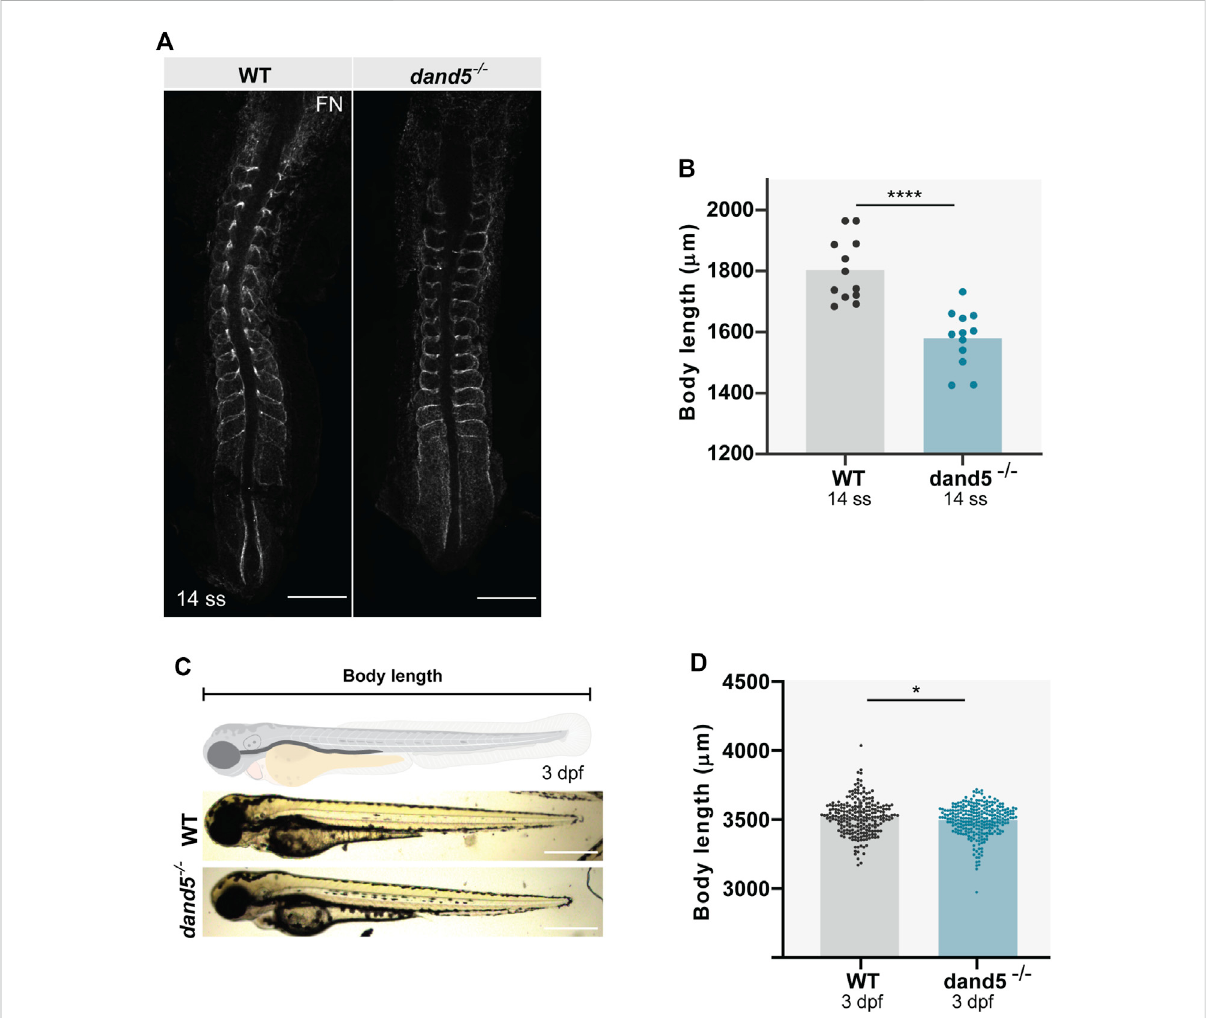
FIGURE 8 Bodysizeandsomitemorphology inWTand dand5 − / − embryos. (A) Fibronectin(FN)immunostainingshows somitebordersinWTand dand5 − / − embryosat14ss.Scalebar=100 µm.Thetopisanterior;thebottomisposterior. (B) ComparisonofWTand dand5 − / − bodylengthat14ss. (C) WTand dand5 − / − 3 dpf larvae and schematic representation of body length measurements. Scale bar = 500 µm. (D) Comparison of body length measurementsbetweenWT( N =234)and dand5 − / − ( N =271)3dpflarvae.GrayrepresentsWTembryos,andbluerepresents dand5 − / − embryos. t -testunpairedcomparison.Barsrepresentmeanvalues,anddotsrepresentindividualembryos.*correspondstoa p -value < 0.05;****corresponds to a p -value <